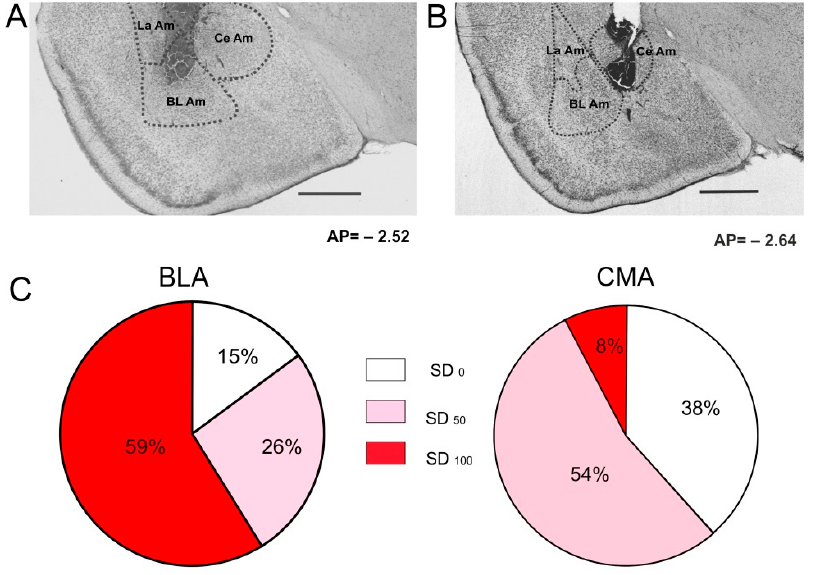
Figure 2. Photomicrographs of the typical amygdala lesion produced by micro-injury of the baso- lateral ( A ) and centromedial ( B ) regions of the amygdala. Scale bar is 1 mm. BLA—basolateral amygdala, Ce Am—central amygdala, La Am—lateral amygdala. ( C ) Pie charts showing prob- ability of SD-triggering by two injuries (100%, 50% and 0%) of BLA and centromedial (CMA) amygdala regions.